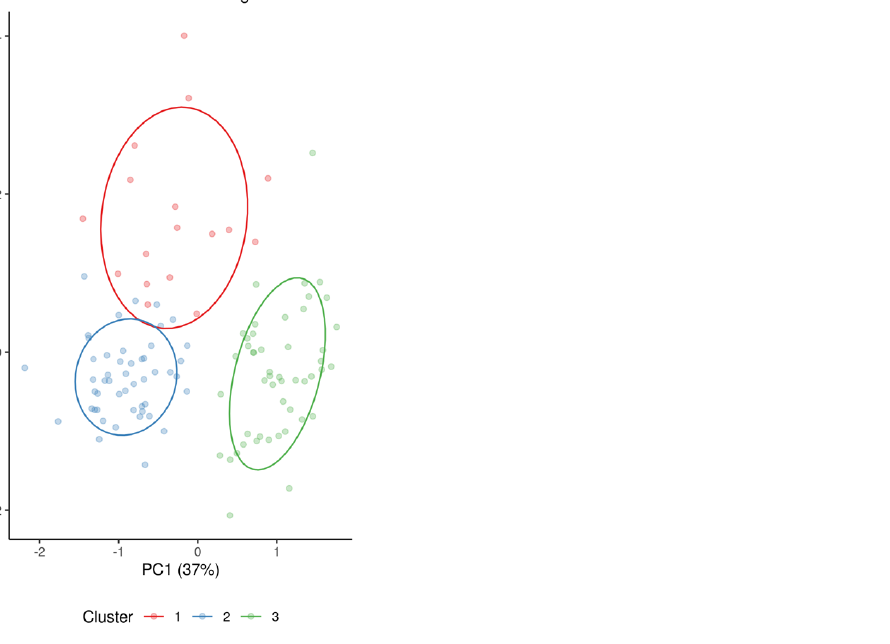
Figure 12. Heatmap showing retained biomarkers in LASSO-regularized classifier for all patients in both training and testing sets. Subjects are clustered into phenotype groups column-wise and hierarchically clustered row-wise. Row-wise Z-scores determine the color of each cell. 3.3. Bioinformatic Analysis of Observed Findings While the following results of bioinformatic analyses shed some light on the biological pathways possibly being affected by the different relative glycoisoform abundances determined in our study, it is important to emphasize that the findings